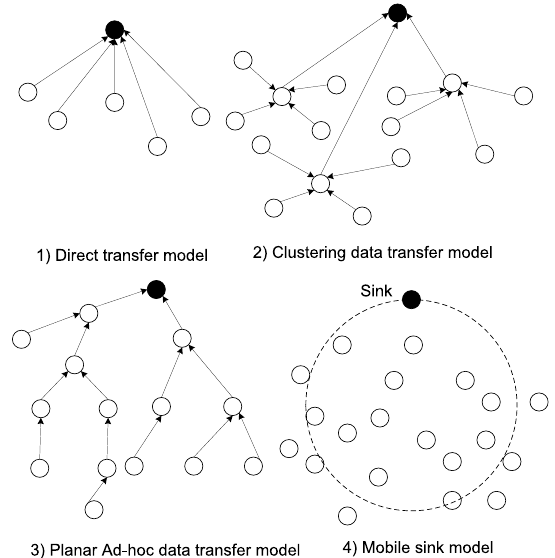
Fig. 5 Data transmission model of wireless sensor